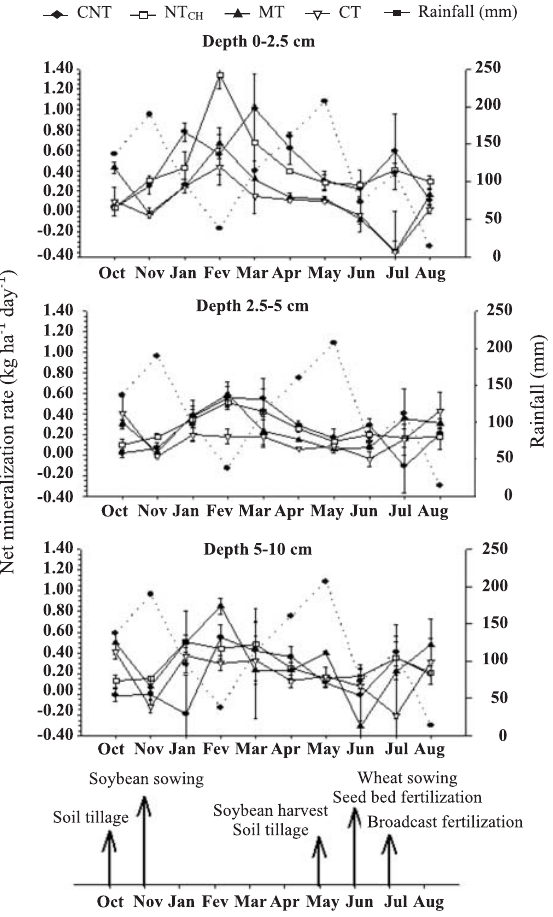
Figure 2. Net mineralization rates in the 0–2.5, 2.5–5 and 5–10 cm layers under continuous no-tillage (CNT), no-tillage with chisel plow (NT minimum tillage (MT) and conventional tillage (CT) from October 2003 to August 2004. The results represent the average ± the